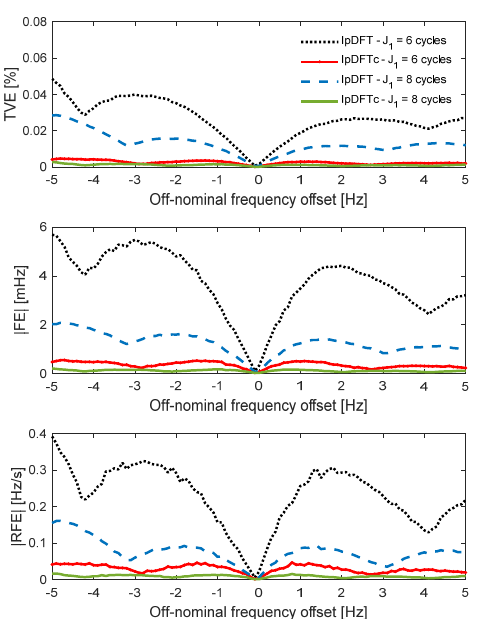
Figure 1. Maximum TVE, |FE|, and |RFE| values over 1000 records of 6-cycle and 8-cycle observation intervals obtained with the classic IpDFT and the IpDFTc estimators as a function of the off-nominal frequency deviations assuming that the first 50 harmonics of amplitude equal to 10% of the fundamental component affect the collected waveform.